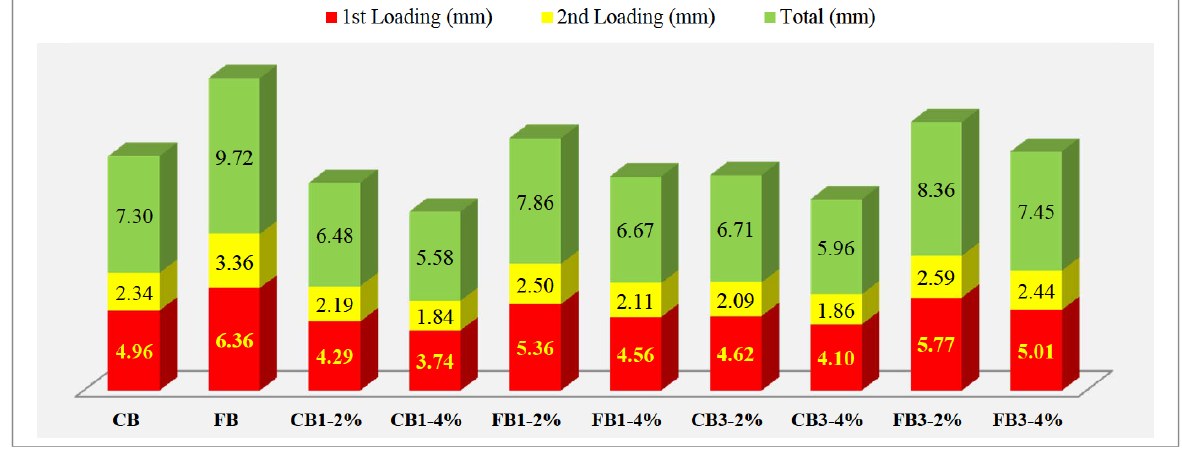
Figure 6: Total vertical deformation rate